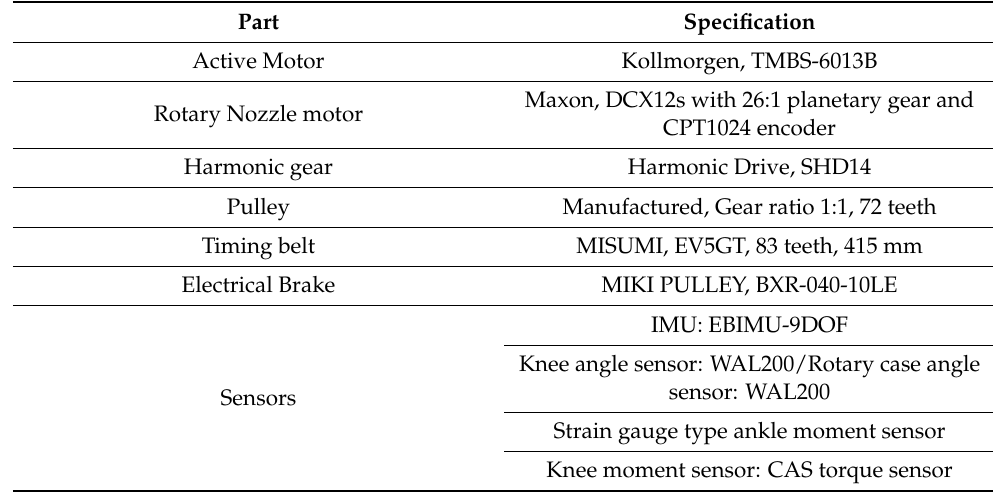
Figure 6. Overall system structure: ( A ) parts diagram of the final prototype; ( B ) final prototype. Table 1. Main parts list of rotary hybrid prosthesis.